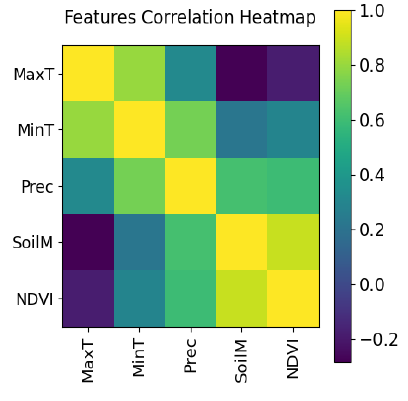
Figure 7. Mufindi district data features (Maximum Temperature, Minimum Temperature, Soil Moisture, Precipitation and NDVI) from 2002/2003 to 2009/2010 maize seasons.